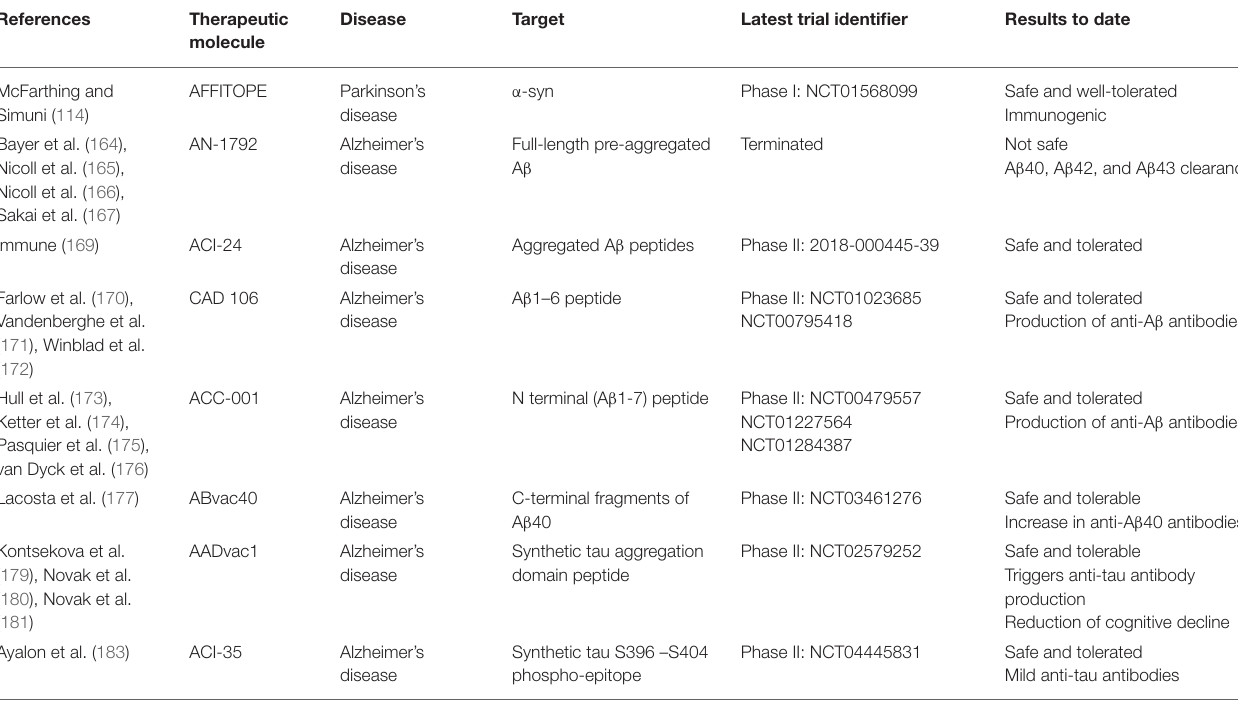
TABLE 1 | Study characteristics of active immunotherapy clinical